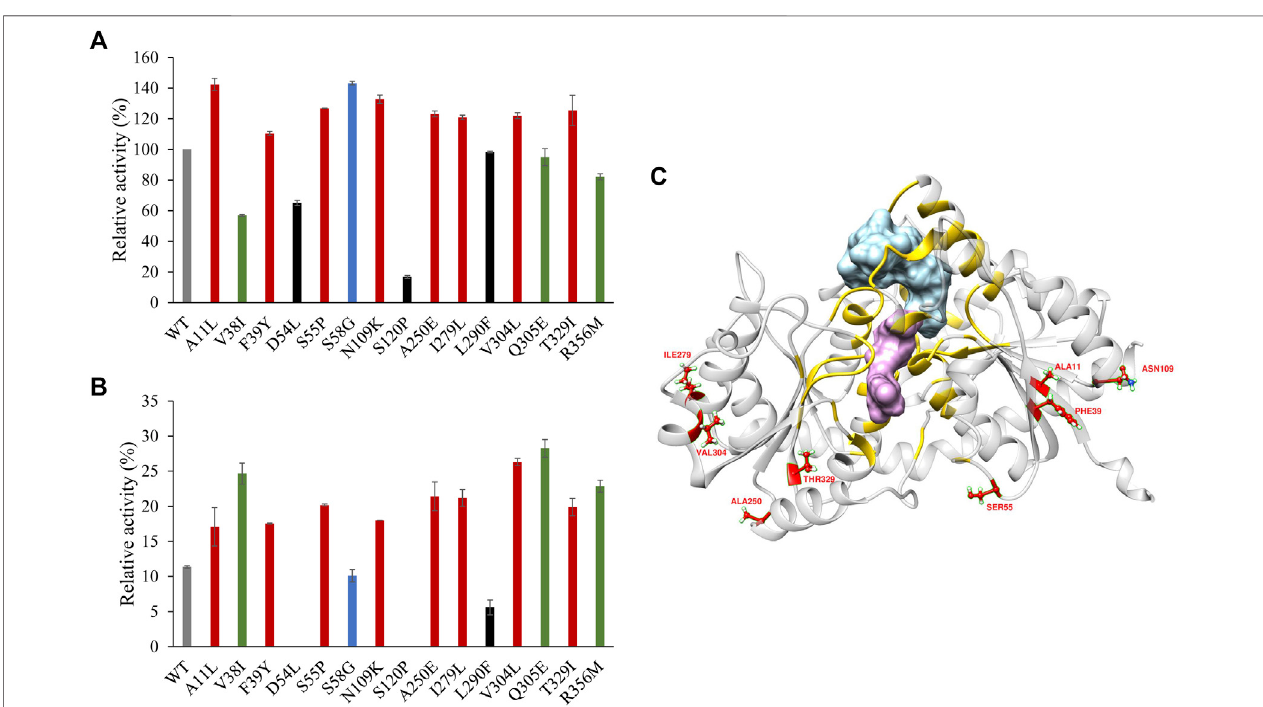
FIGURE5|(A) EnzymeactivityofPgUGTvariants. (B) ThermostabilityofPgUGTvariants.Red,variantswithbothhigherenzymeactivityandbetterthermostability; green, variants with only better thermostability; blue, variants with only higher enzyme activity; black, variants with both reduced enzyme activity and worse thermostability. (C) PgUGT model docked with Reb A and UDP-glucose. Blue, Reb A; purple, UDP-glucose; yellow, residues around Reb A and UDP-glucoside within 6 Å. Error bars represent standard deviations, and three replicates were performed.